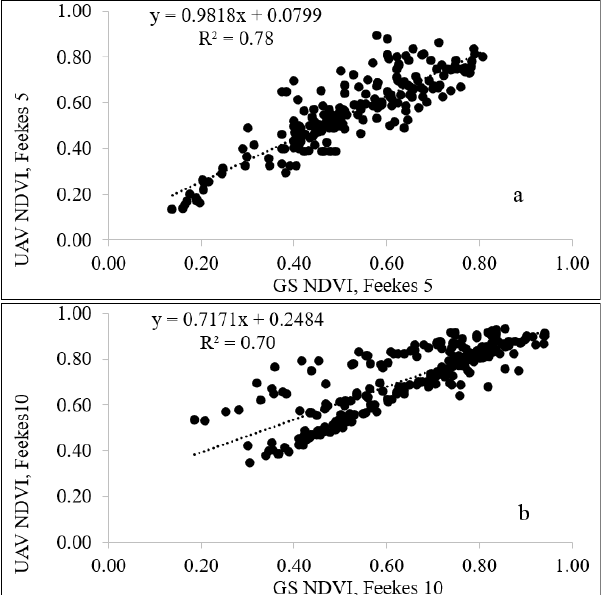
Figure 2. Relationship between Normalized Difference Vegetative Index (NDVI) at Feekes 5 ( a ) and Feekes 10 ( b ) growth stages collected using the GreenSeeker (GS) sensor and the Unmanned Aerial Vehicle (UAV) 3D Robotics 8X+ octocopter equipped with MicaSense Red Edge™ 3